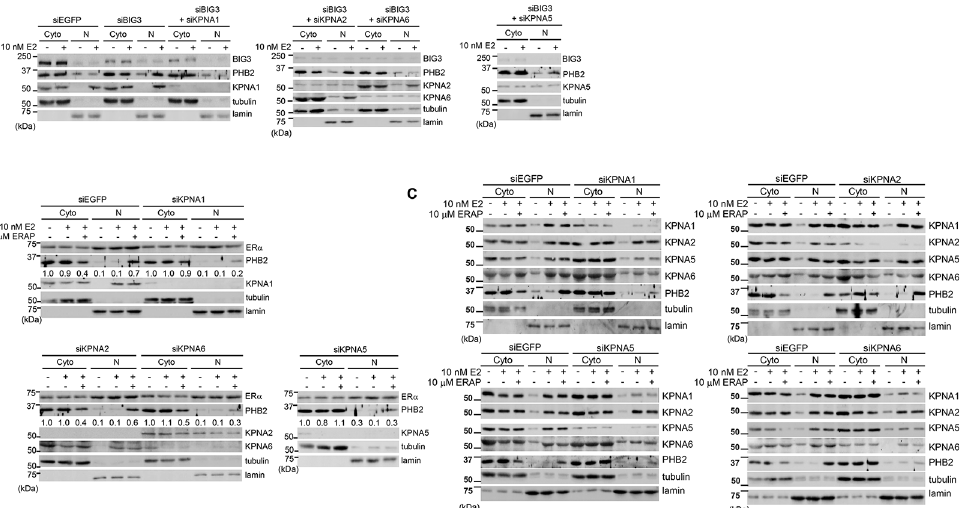
Fig 3. KPNA1, KPNA5, and KPNA6 are required for E2-dependent PHB2 nuclear import in breast cancer cells. (A) Immunoblotting analysis was performed to evaluate the subcellular localization of endogenous PHB2 in the BIG3- and KPNAs (KPNA1, KPNA5, and KPNA6)-depleted MCF-7 cells. MCF- 7 cells were treated with siBIG3 and each siKPNA, followed by E2 ± ERAP for 24 h. Then, the cells were separated into cytoplasmic and nuclear fractions; (B) The nuclear translocation of PHB2 in KPNA-depleted MCF-7 cells in the presence of E2 and ERAP was evaluated. MCF-7 cells were treated with each siKPNA followed by E2 ± ERAP for 24 h. Then, the cells were separated into cytoplasmic (Cyto) and nuclear (N) fractions. The data are expressed the fold increase over cytoplasm fraction of untreated siEGFP, siKPNA1, siKPNA2, siKPNA5 or siKPNA6-transfected cells (set at 1.0), respectively. (C) The relationship among each KPNA was evaluated in KPNA-depleted MCF-7 cells in presence of E2 and ERAP. α / β -Tubulin (tubulin) and lamin B1 (lamin) were used as loading controls for the cytoplasmic (Cyto) and nuclear (N) fractions, respectively (A, B). Full-length images of immunoblots are shown in S3A – S3C Fig.